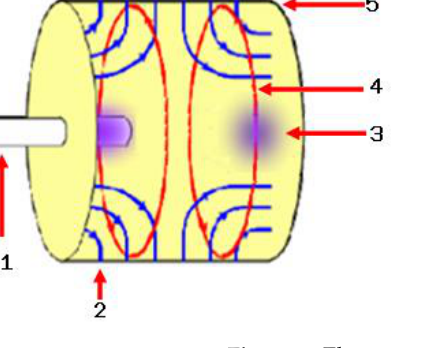
Figure 1. Electromagnetic field propagation in TM 011 wave guide. The focal point of the wave guide is located in the center of the wave guide at 6 cm (half-wavelength) from the magnetron antenna [12]. The electric field amplitude in this focal point has a very high magnitude, while the dimension of the focal volume is estimated to be around 1 cm 3